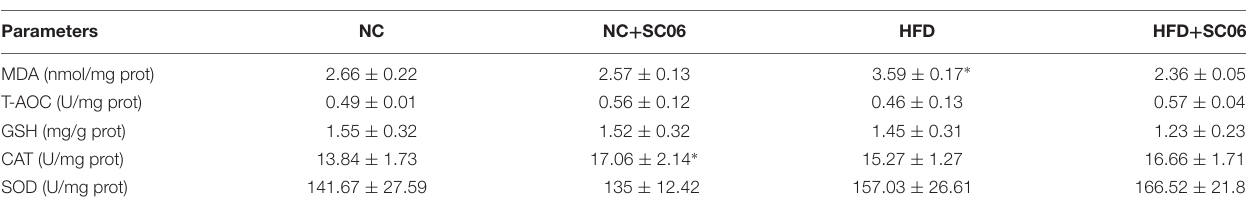
TABLE 1 | HFD and SC06 effects on liver antioxidant parameters.